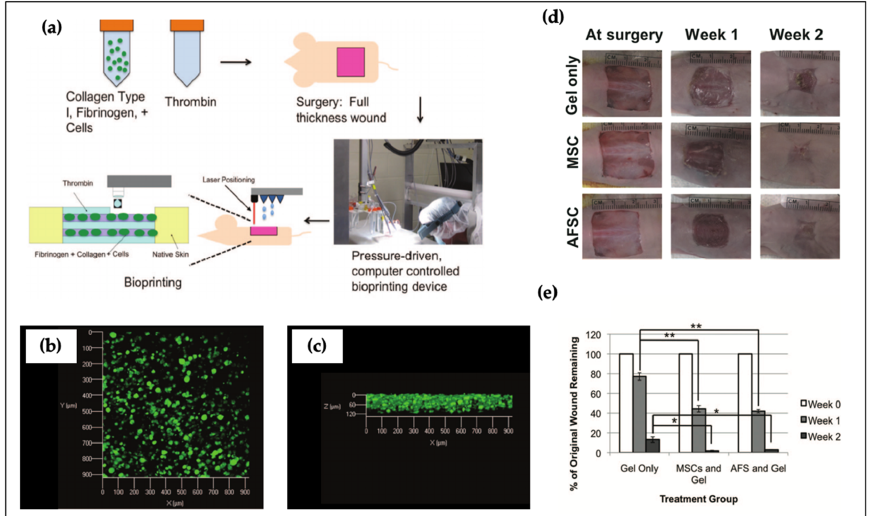
Figure 7. Biofabrication of artificial skin with hybrid bio-inks and assessment of wound closure by cell-free and cell treatment. ( a ) Schematic diagram of biofabrication process for wound closure; ( b , c ) cell distribution of top and side view after 24 h of culture; ( d ) histological results of wound closure and ( e ) wound remaining rate through the use of different treatments. Significance: *, p < 0.05; **, p < 0.01 Reproduced with permission from [78]. Copyright 2012 John & Wiley Sons.